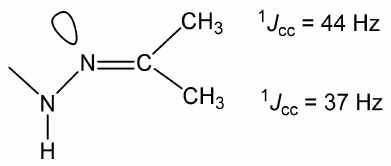
Figure 7. Values of the 13 C- 13 C constants of the imine carbon atom with carbon atoms of the methyl group.